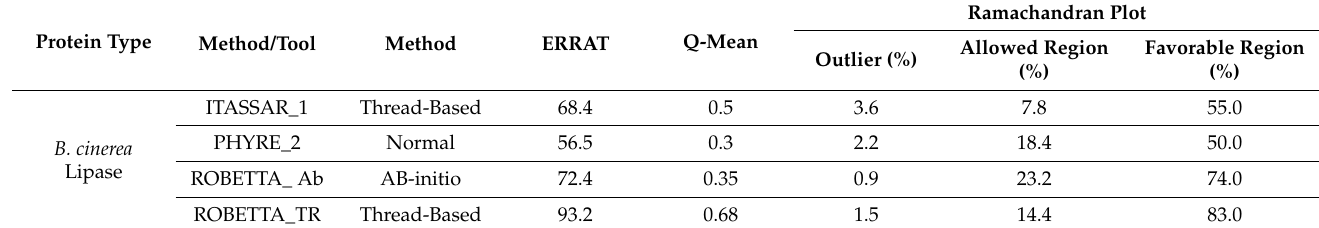
Table 2. Thread-based and ab initio scores for protein modeling. Scores obtained from output models of I-TASSER, Phyre2, and Robetta ab initio TR are shown. Robetta-TR models with best scores were selected.